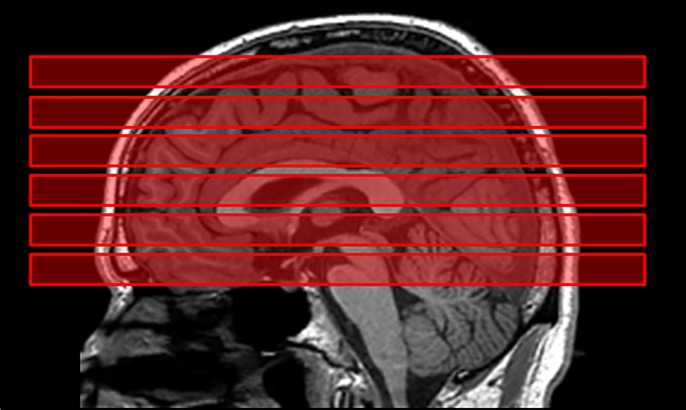
Placement of the Six Slabs in Multiplanar Chemical Shift Imaging (MPCSI).We acquired MR spectroscopy data in six axial oblique slabs through the brain, with each slab comprising a 24 x 24 matrix of 1 cm3 voxels with 2 mm gap between adjoining slabs. The second slab from the bottom was placed such that it contained the anterior commissure (AC) and the posterior commissure (PC). We placed one slab below and 4 slabs above the AC-PC slab, thereby generating metabolite maps across the entire brain in each participant.